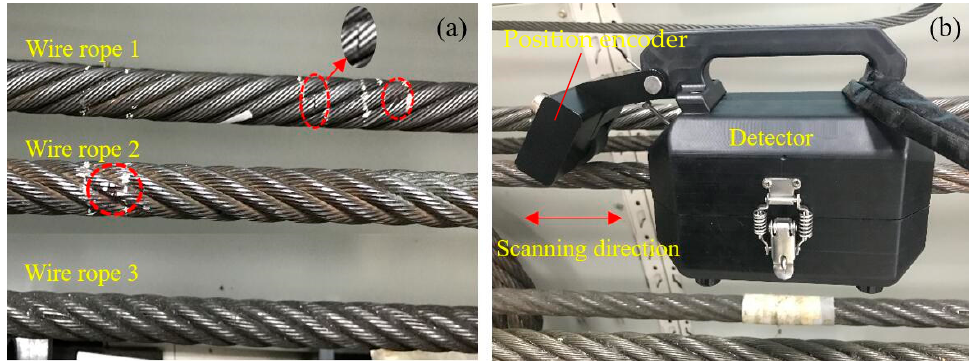
Figure 1. Experimental samples and apparatus. ( a ) Different steel wire ropes; ( b ) MFL detector.